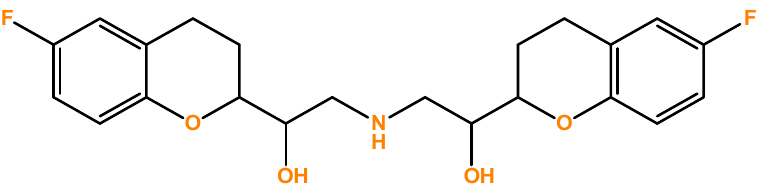
Figure 1. Chemical structure of drug Nebivolol (NEB).